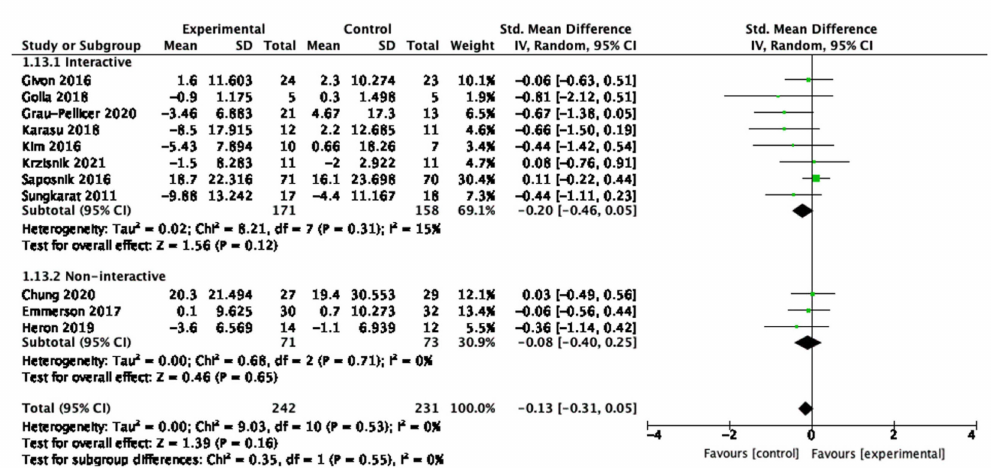
Figure 12. Subgroup analysis for participant interactivity with the digital interventions that measured sedentary behaviour outcomes.